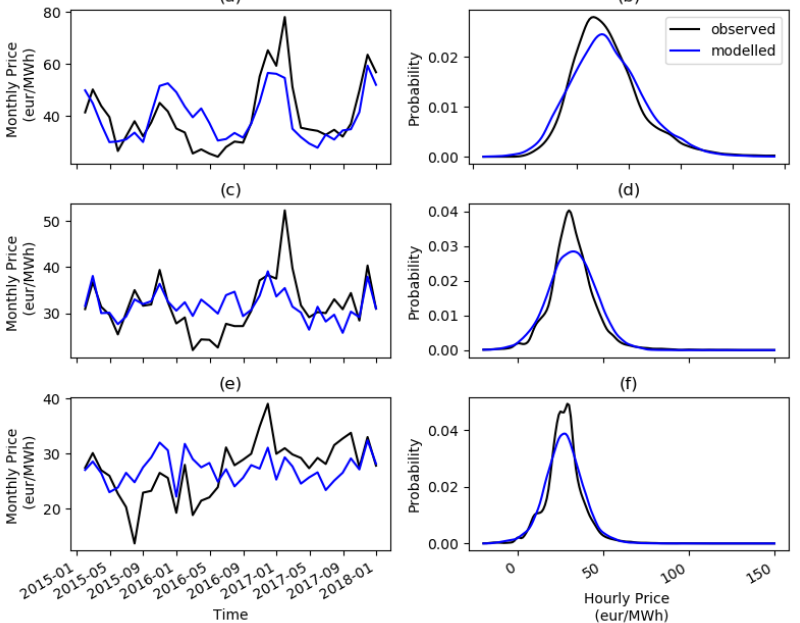
Figure A3. Time series (left) of monthly average prices and estimated probability density function of hourly prices for the period between 1st January 2015 and 31st December 2017. France: ( a , b ); Germany: ( c , d ); and Denmark: ( e , f